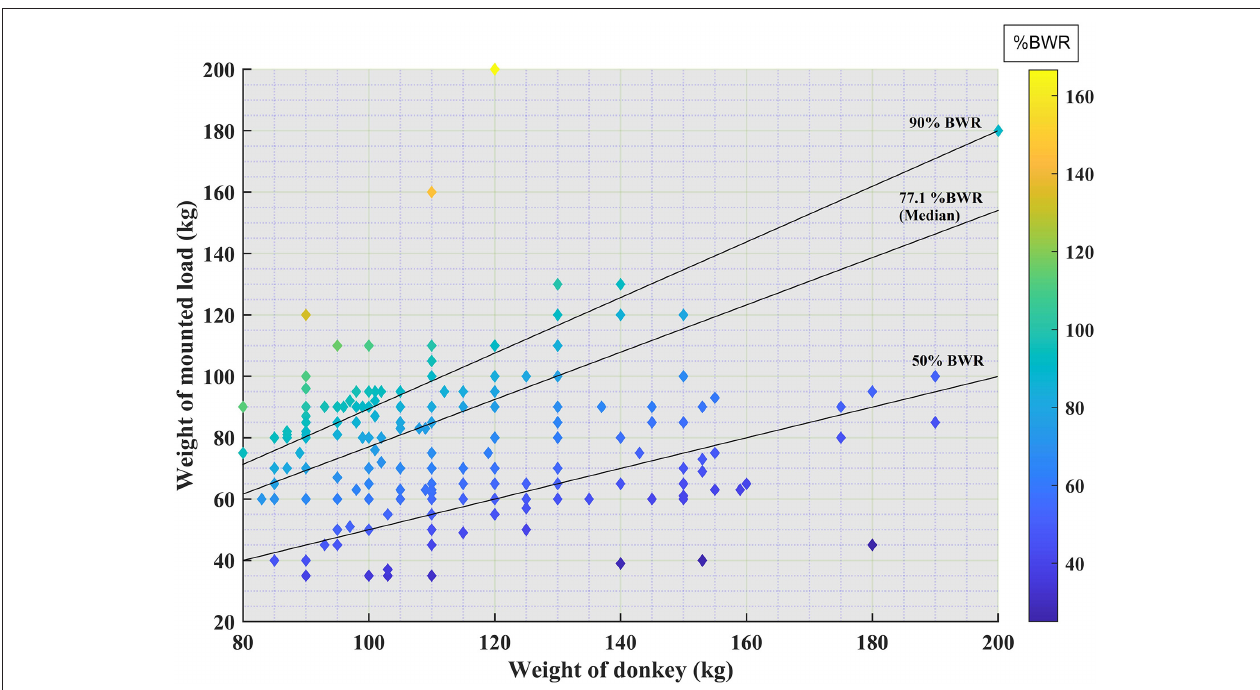
FIGURE 3 | Donkey weight plotted against load carried. Lines represent 50% bodyweight ratio (BWR) carried, the median %BWR and high BWR (the upper quartile for %BWR). Lighter colors represent a higher %BWR.